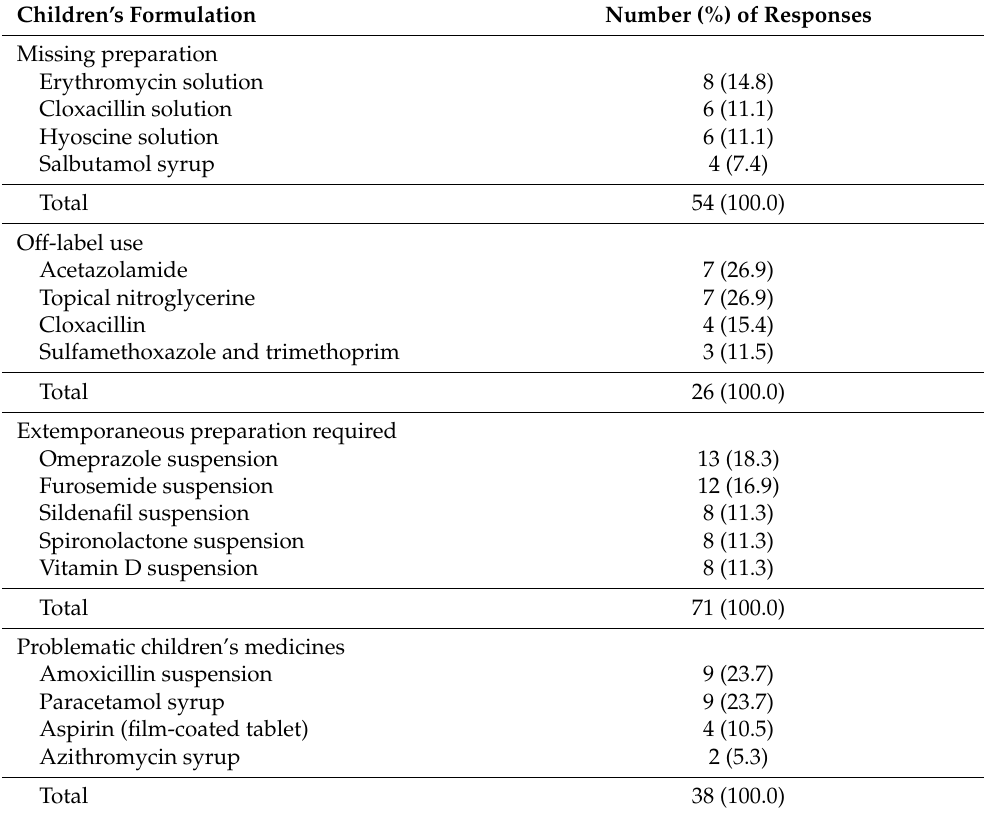
Table 5. Most needed children’s formulations are unavailable in the hospital, as mentioned by